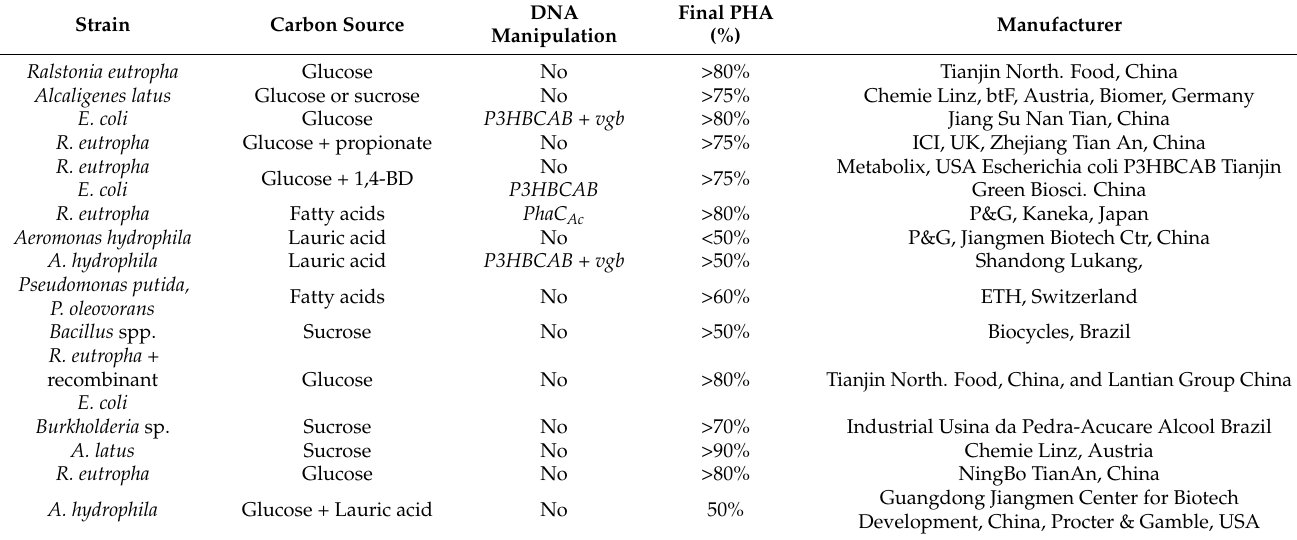
Table 2. Bacterial strains for pilot and large-scale production of